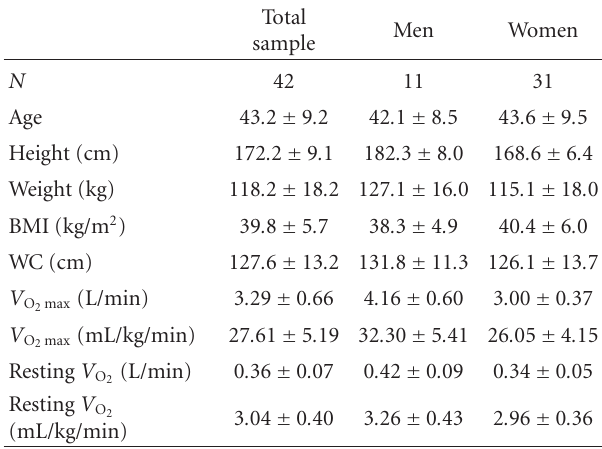
: n = 2 max : maximal oxygen 2 max